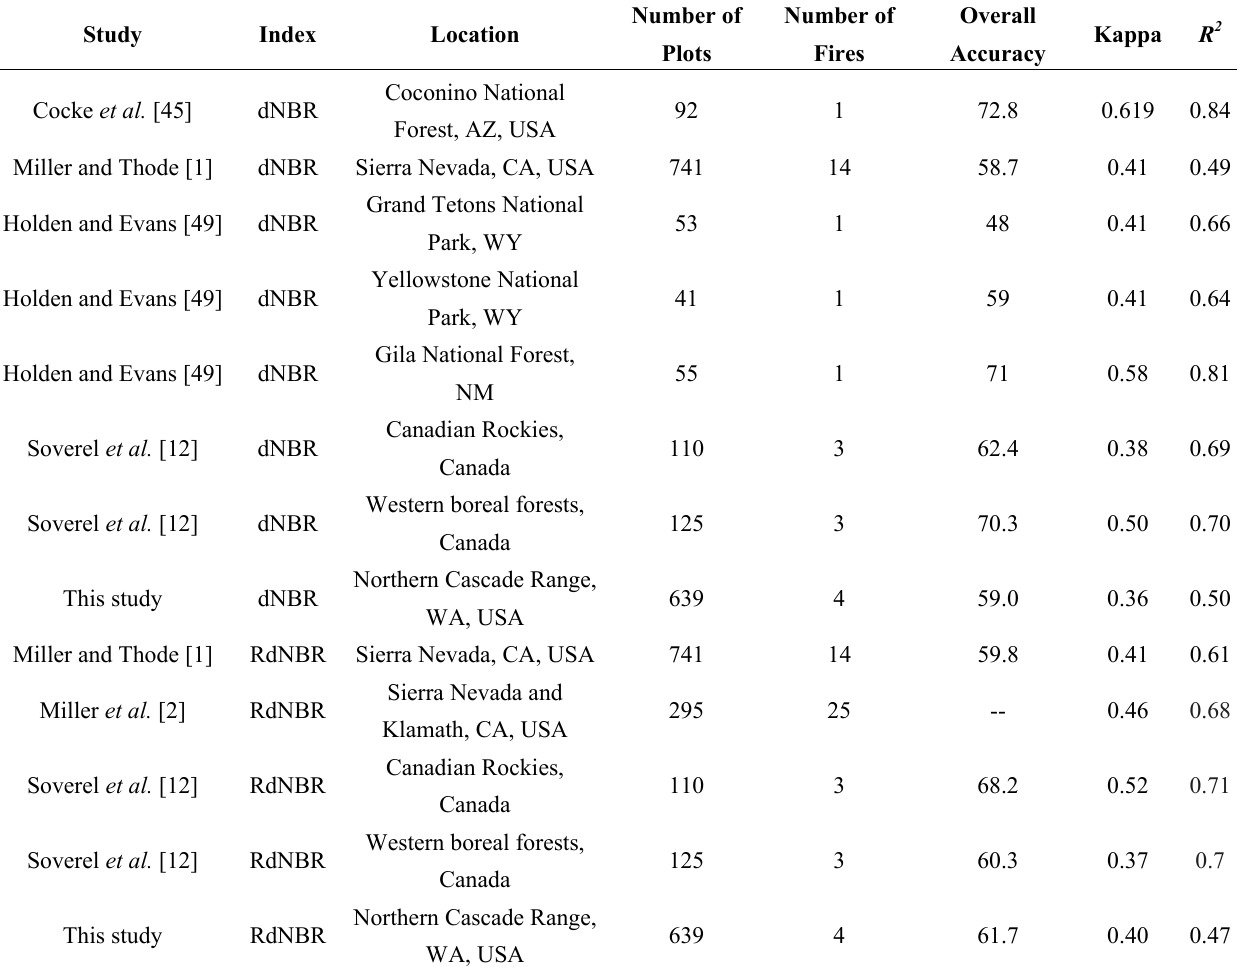
Table 12. Classification results for the northern Cascade Range compared to other studies in coniferous forest in North America that use CBI to classify dNBR and